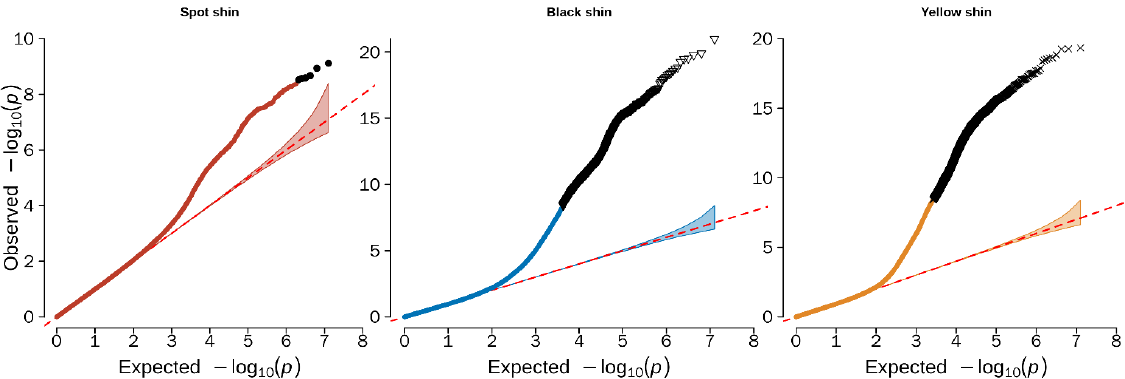
Figure 3. Quantile – quantile (Q – Q) plots of the GWAS for the shin color trait in ducks. The Q – Q plots show the late separation between the observed and expected values. The red dotted lines indicate the null hypothesis of no true association. Deviation from the expected p -value distribution is